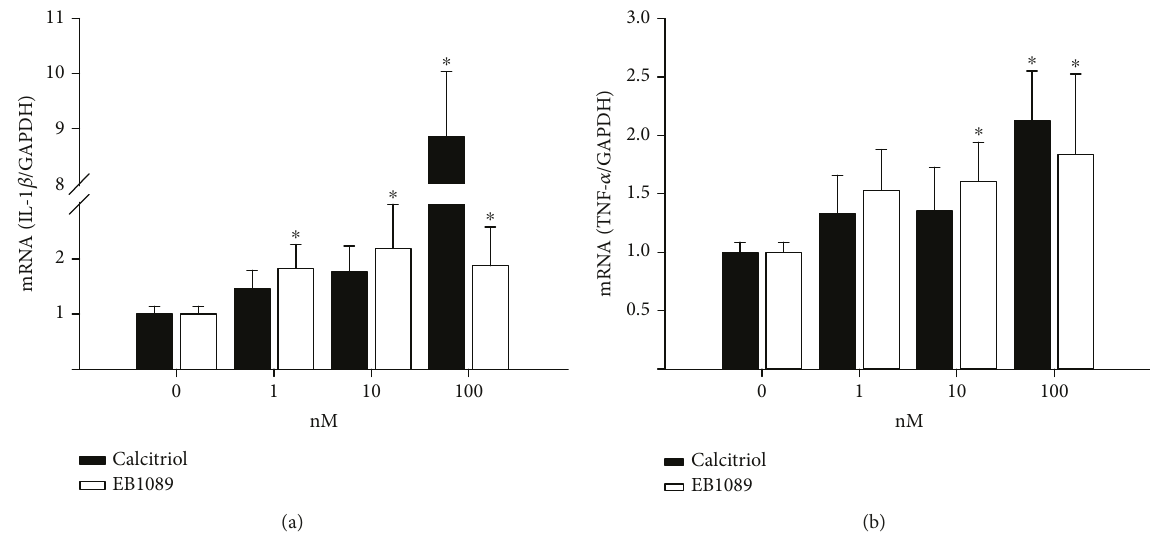
Figure 4: Calcitriol and its analogue increased IL-1 β and TNF- α gene expression in SUM-229PE cells. Cells were cultured in the absence or presence of di ff erent concentrations of calcitriol (black bars) or EB1089 (white bars) for 24 hours. (a) IL-1 β and (b) TNF- α gene expression was assessed by qPCR. The results represent the average of at least 3 experiments in triplicate ± SD . ∗ P < 0 05 vs. control (0). For data normalization, gene expression in cells without treatment was considered as one. Table 2: IL- β and TNF- α secretion induced by calcitriol and its analogue in breast cancer cell lines. SUM-229PE